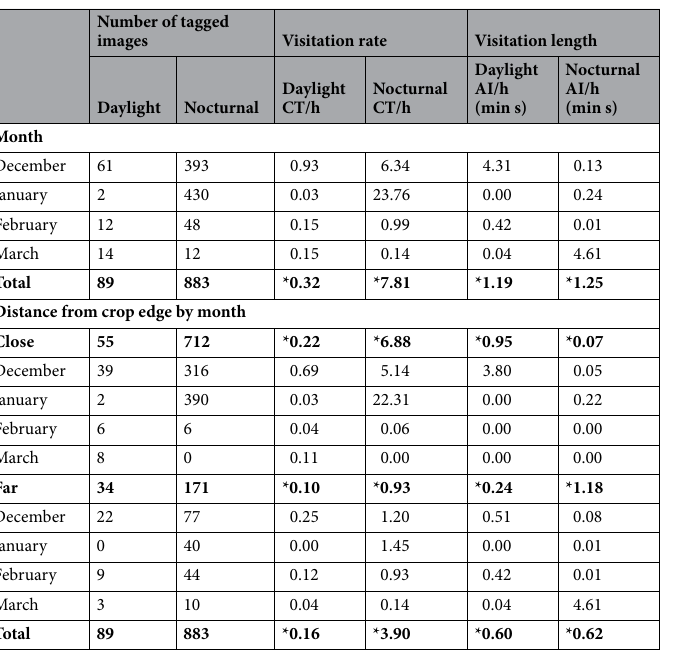
Table 2. The number of tagged images from camera traps, the visitation rate expressed as camera trap images per hour (CT/h) and the visitation length expressed as an activity index (AI/h). Average visitation rate and length denoted with an asterisk. Bold values indicate a significant p-value